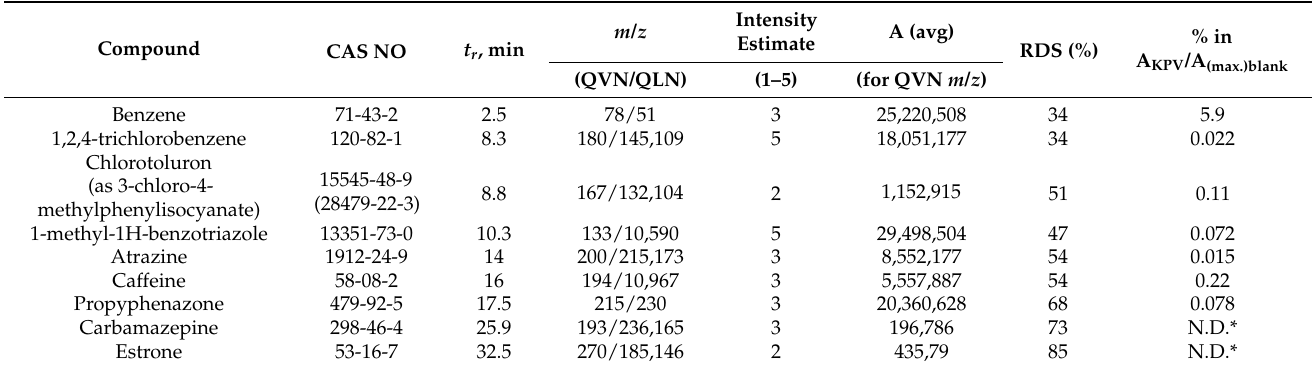
Table 1. Composition of control solution QC4 and results of the analysis with results of repeatability experiments with 6 samples of QC4 and removal efficiency for compounds.